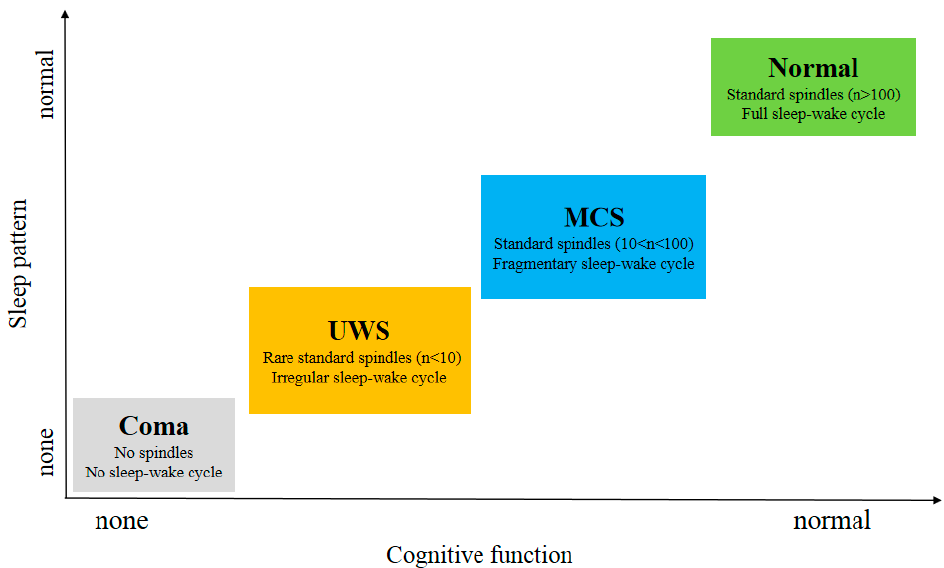
Figure 3. Sleep pattern and cognitive function. The awareness and cognitive function of patients with disorders of consciousness, such as UWS or MCS patients, can be assessed from sleep pat- terns. The sleep–wake cycle and the number of sleep spindles can reflect the state of consciousness. Abbreviations: UWS, unresponsive wakefulness syndrome; MCS, minimally conscious